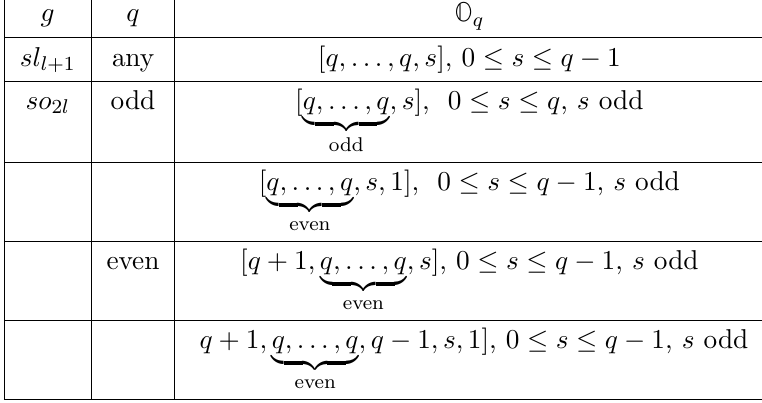
Table 7 . Orbits in A and D type Lie algebras.